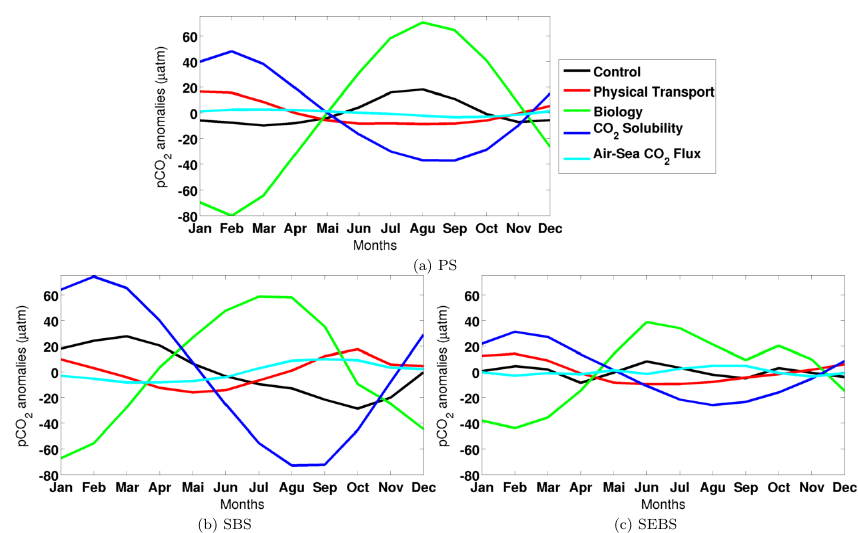
Figure 10. Temporal evolution of the monthly anomalies of each process in regulating p CO 2 anomalies, green line represents the biological production, red line the physical transport, light blue line the air-sea CO 2 fluxes and dark blue line the CO 2 solubility. Black lines represent the temporal p CO 2 anomalies.